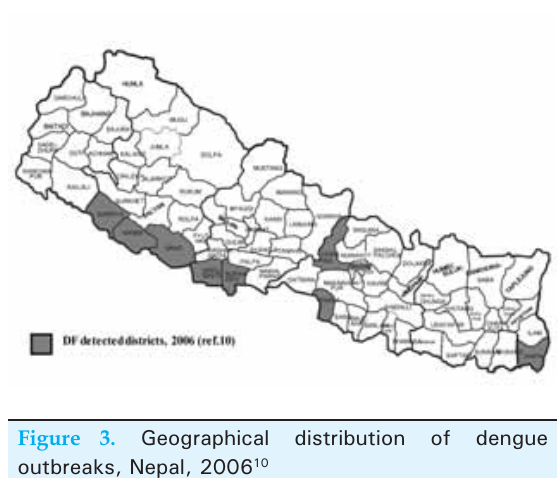
Figure 3. Geographical distribution of dengue